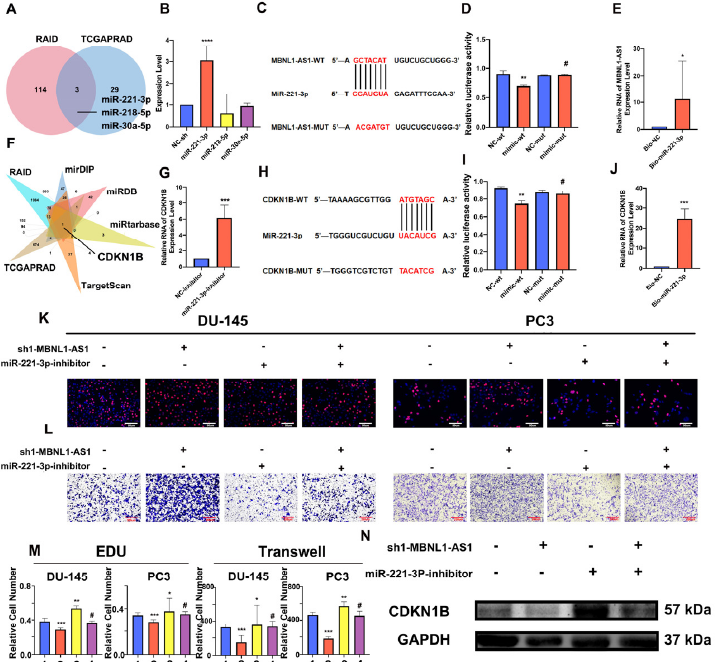
Figure 5. MBNL1-AS1 promotes PC malignancy through the miR-221-3p/CDKN1B axis. ( A ) The TCGA-PRAD and RAID databases were combined to predict the downstream miRNA targets of MBNL1-AS1 action. ( B ) Target miRNA expression levels were assessed by qPCR in PC3-CSCs. ( C ) The sequence of plasmid of MBNL1-AS1. ( D , E ) Dual luciferase ( D ) and pull-down ( E )